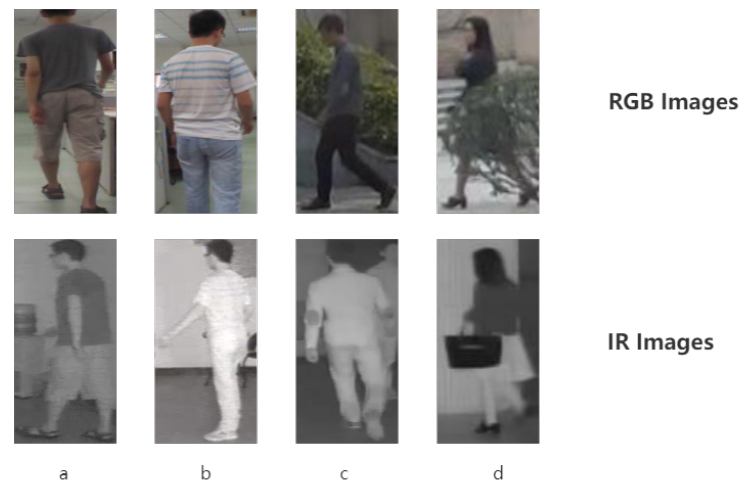
Figure 1. Four people are depicted: ( a – d ). The RGB images in the first row were taken with an RGB camera under good lighting conditions and contain the most important three-channel color information related to pedestrian appearance.The IR images in the second row were taken by an IR camera at night and only contain single-channel heat information. There is a one-to-one correspondence between infrared image and RGB